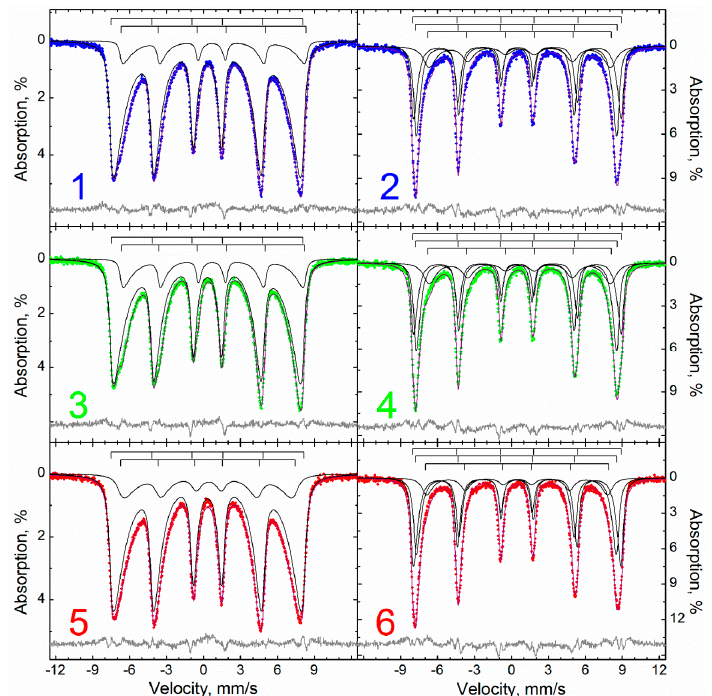
Figure 4. Description of the Mössbauer spectra within the model of multilevel superparamagnetic relaxation of the samples: 1, 3, 5—M, MA, MAox measured at 295 K, and 2, 4, 6—M, MA, MAox measured at 78